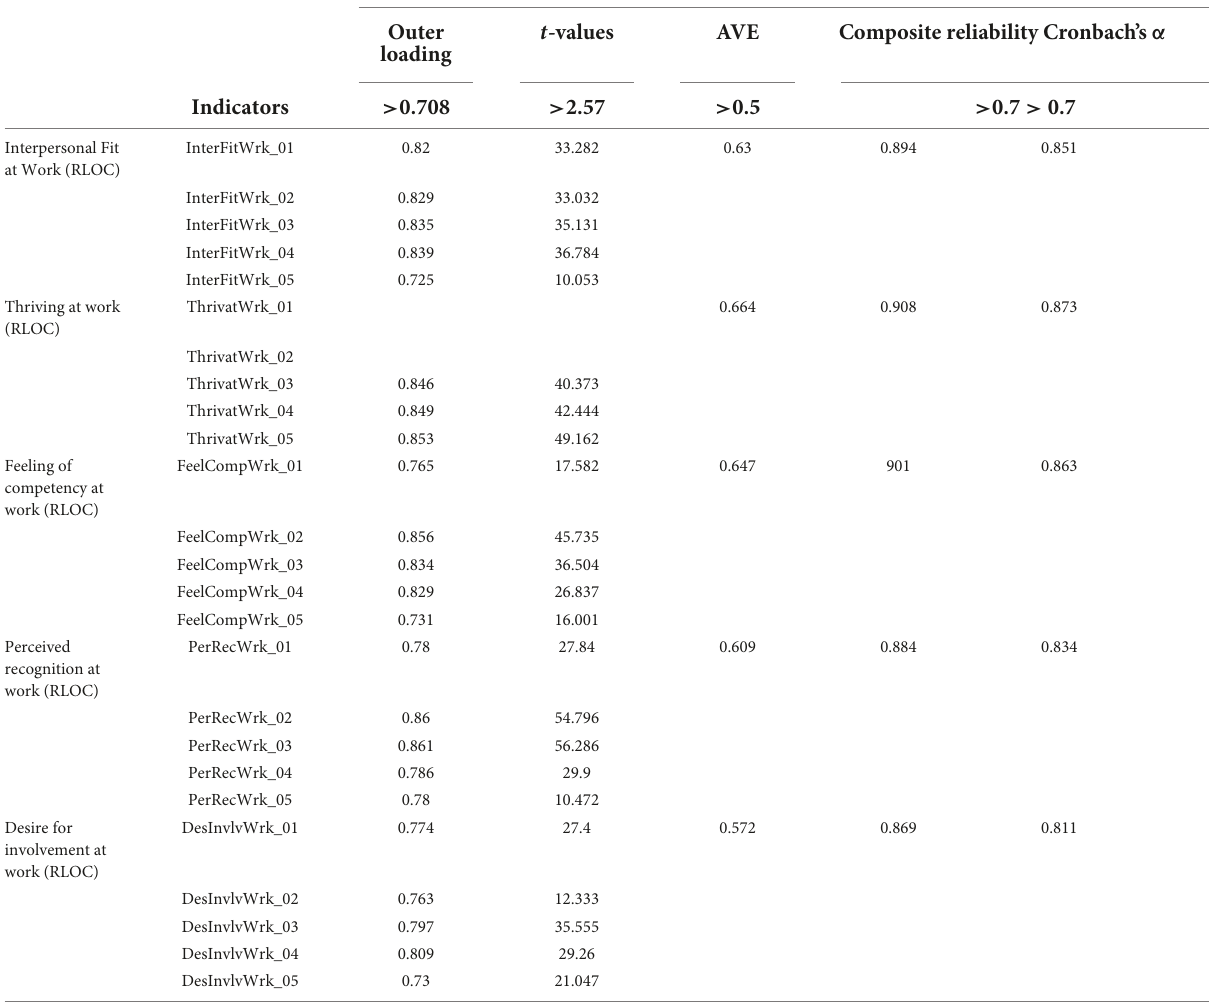
TABLE 1 Convergent validity, Cronbach’s alpha, and composite reliability of well-being. Well-being